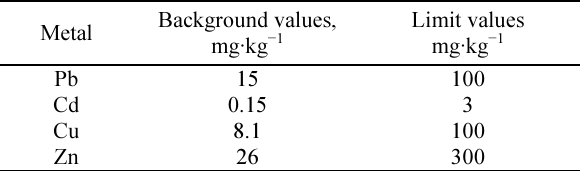
Table 2. Background and limit values of heavy metals for Lithuanian moderate sandy soil (Hygiene Standard of Lithuania HN 60:2004)